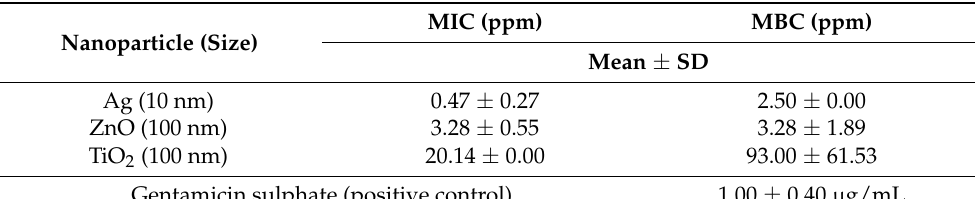
Table 3. Results of antimicrobial activity investigation of metal and metalo oxide nanoparticles on model microorganism MRSA MFBF 10679 by serial micro dilution broth assay (MIC—minimal inhibitory concentration; MBC—minimal bactericidal concentration; n =